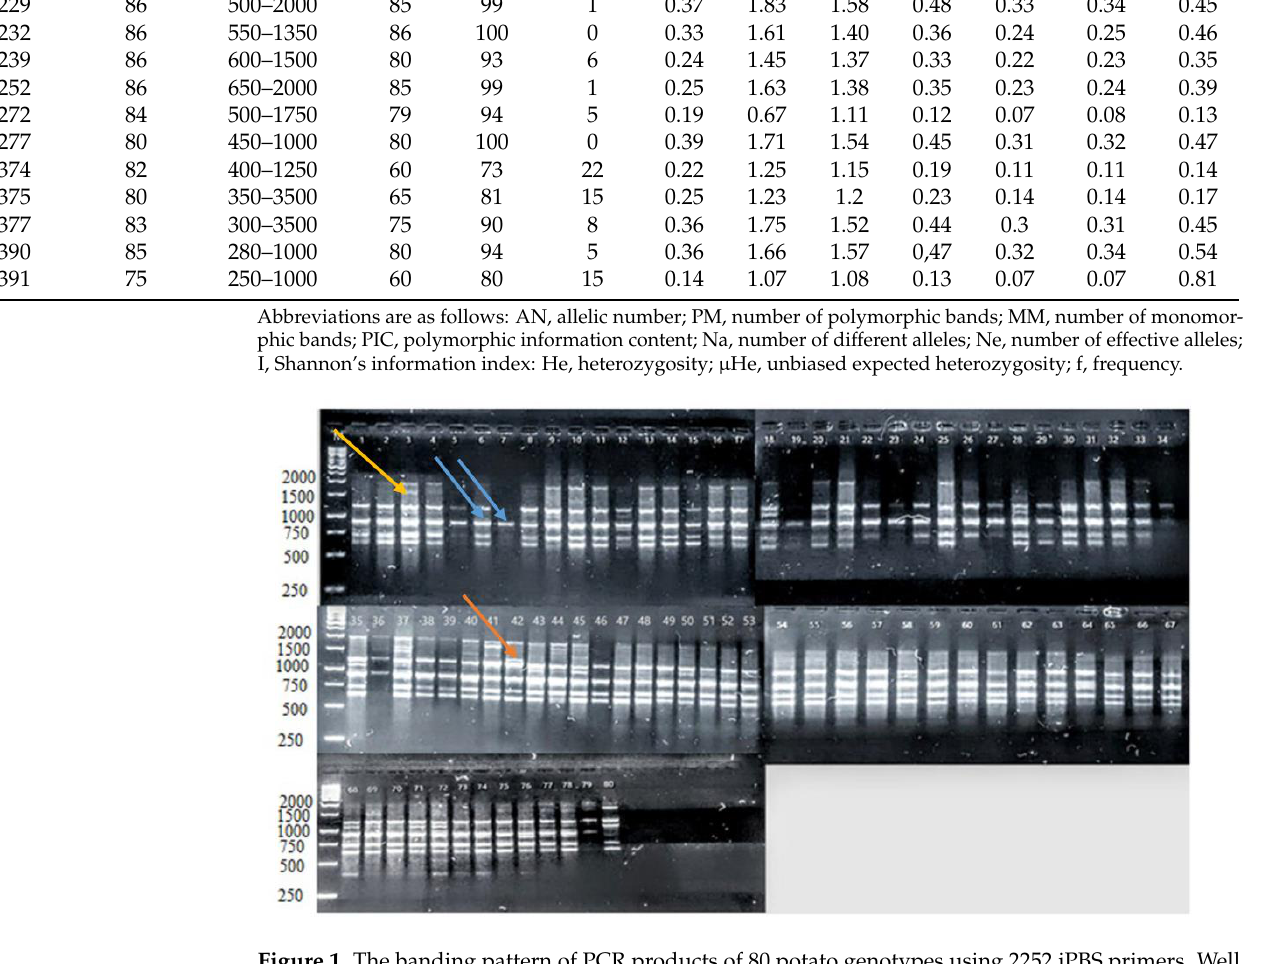
Figure 1. The banding pattern of PCR products of 80 potato genotypes using 2252 iPBS primers. Well 1 includes a 1 kb size ladder, wells 2 – 30 include local strains, wells 31 – 35 are local cultivars, wells 36 – 46 represent NARC accessions, and wells 47 – 80 contain exotic cultivars. Orange-colored arrows point to polymorphic alleles of sizes 1, 700 bp, and blue-colored arrows point to monomorphic alleles of size 900 bp, while the red color represents a unique allele of size 1, 300 bp.